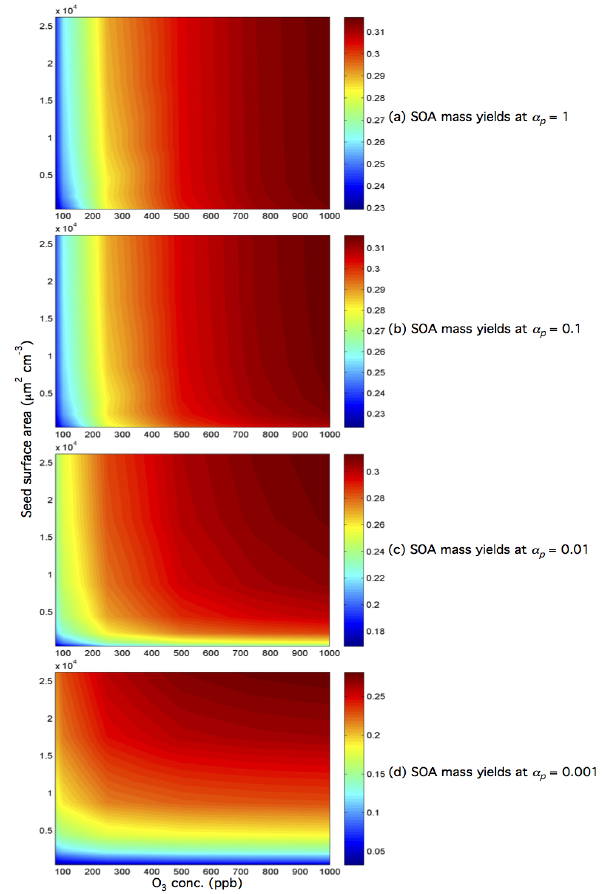
Figure 6. SOA mass yields at peak SOA growth as a function of both the seed surface area and O 3 concentration for α p = 1, 0.1, 0.01, and 0.001. The SOA mass yields at peak SOA growth are indi- cated by colors and contours. Note that the color bars for panels (a, b, c) have different SOA mass yield ranges. Simulations were car- ried out using the optimal branching ratios, oligomerization rate, and vapor wall deposition rate parameters obtained in this study. The initial α -pinene concentration was set to 50ppb, and a fixed O 3 concentration was used in place of a linear